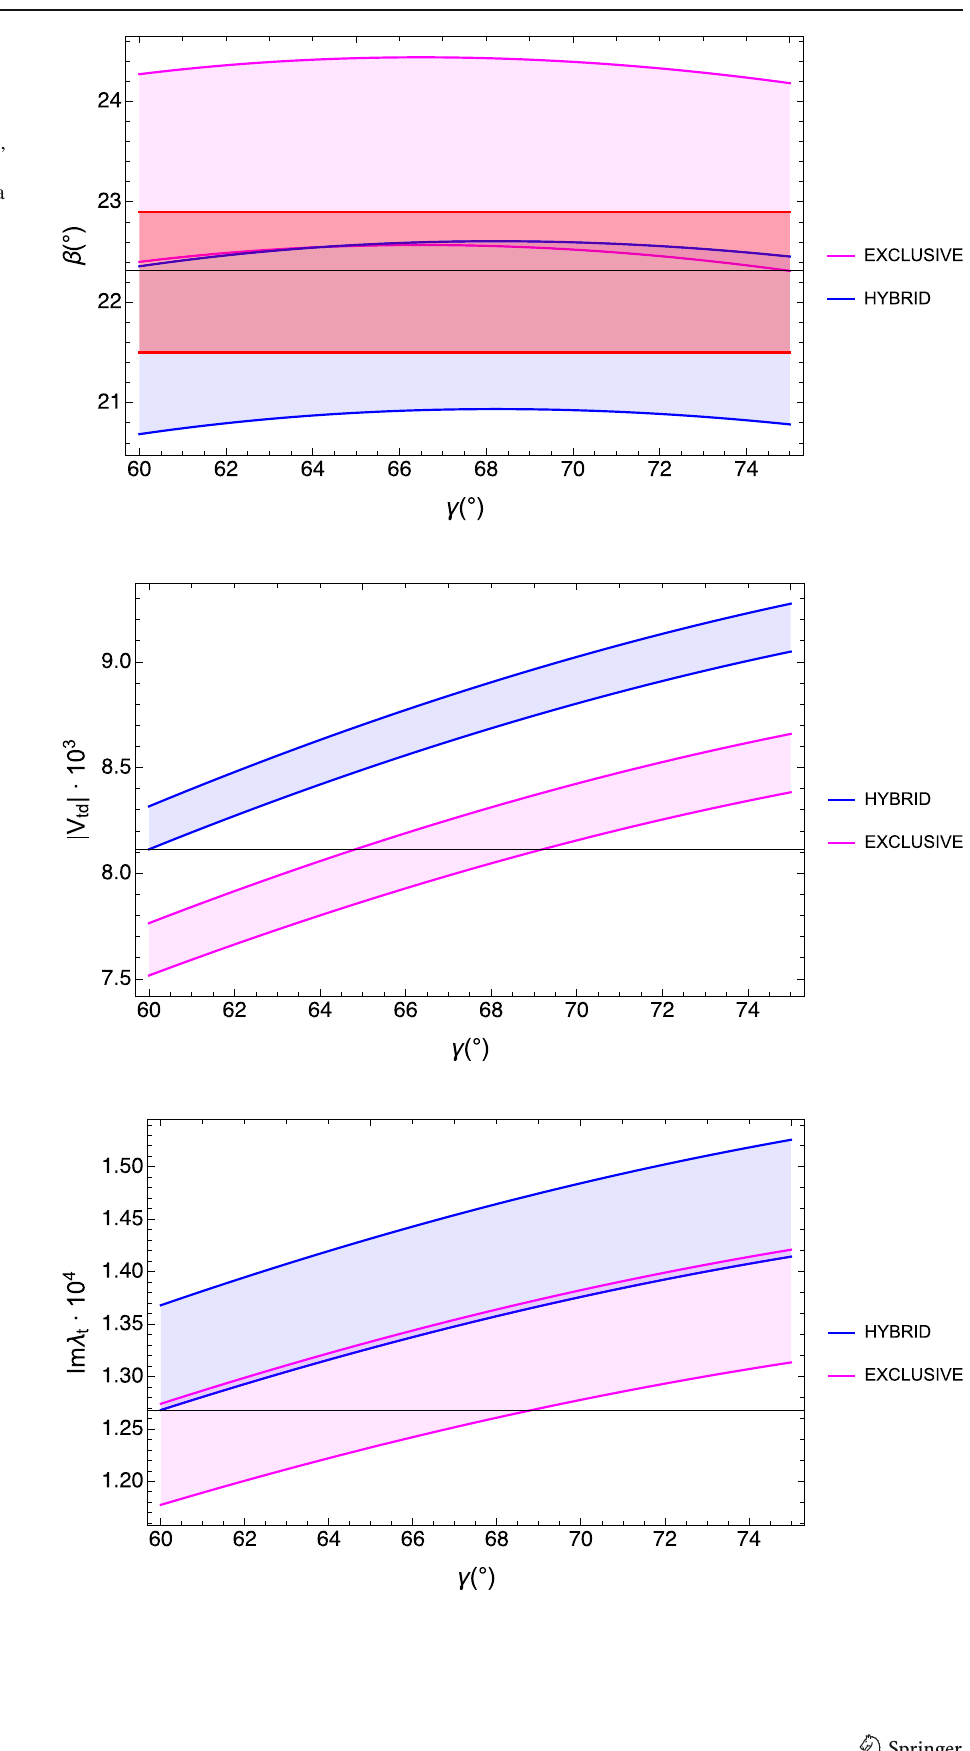
Fig. 2 The UT angle β as functions of γ , in the EXCLUSIVE and HYBRID scenarios. The bands represent the uncertainties related to | V cb | , | V | and | V | . The one-sigma ub us range for β in (10) is shown as a red band